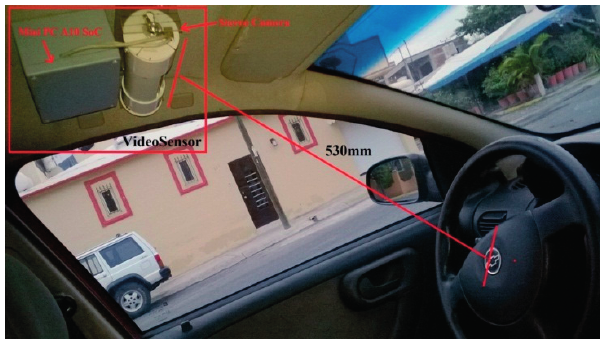
Figure 10. Video sensor platform